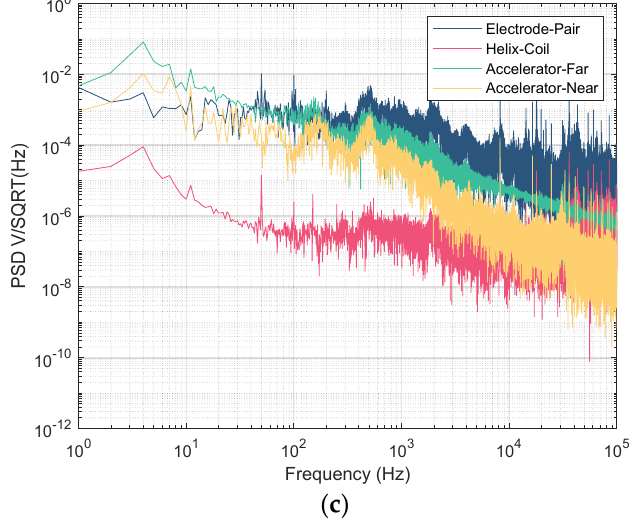
Figure 12. Received frequency domain signals of the improved experimental section. ( a ) Low vibration speed. ( b ) Medium vibration speed. ( c ) High vibration speed.